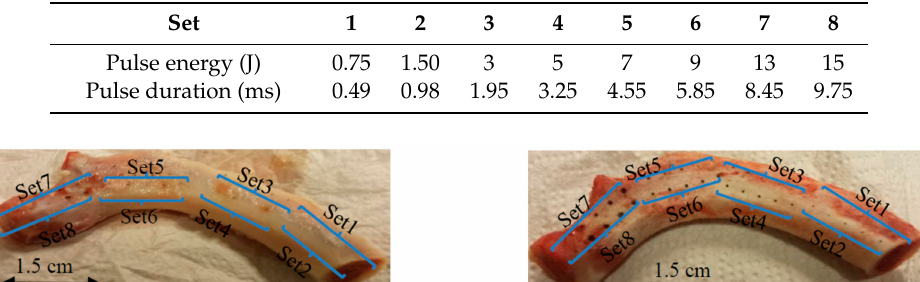
Table 1. Summary of the laser parameters.